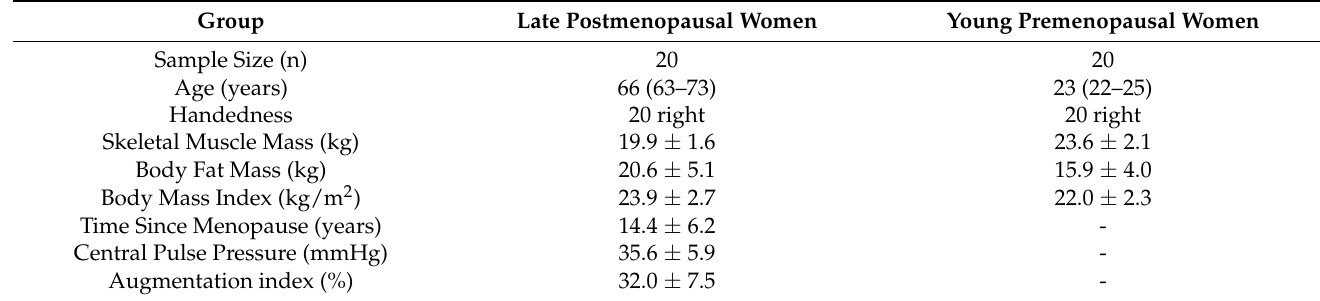
Table 1. Demographic